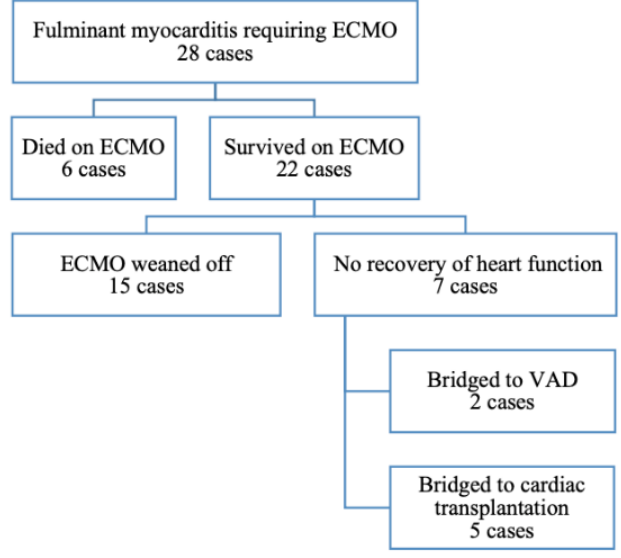
Figure 1. Study population. ECMO extracorporeal membrane oxygenation; VAD ventricular assist device.